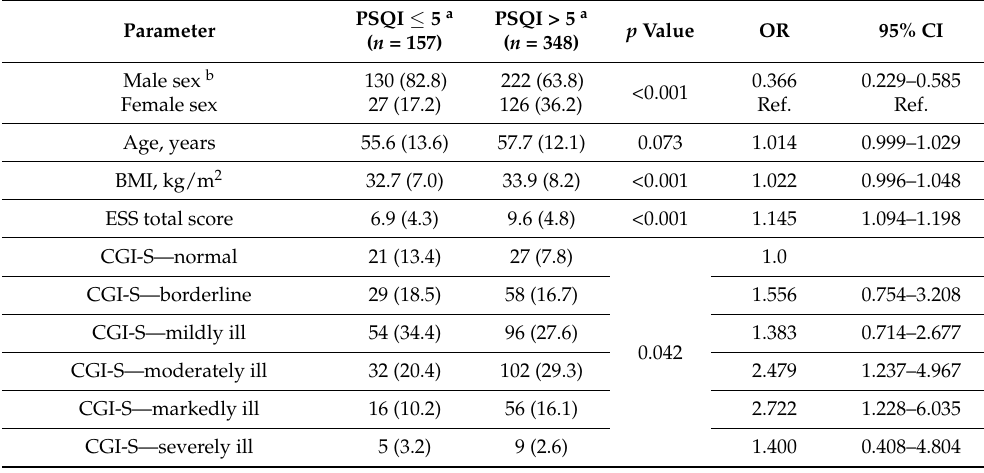
Table 2. Differences in the demographic and clinical parameters according to the quality of sleep measured using the PSQI, as well as associations of the parameters with poor sleep